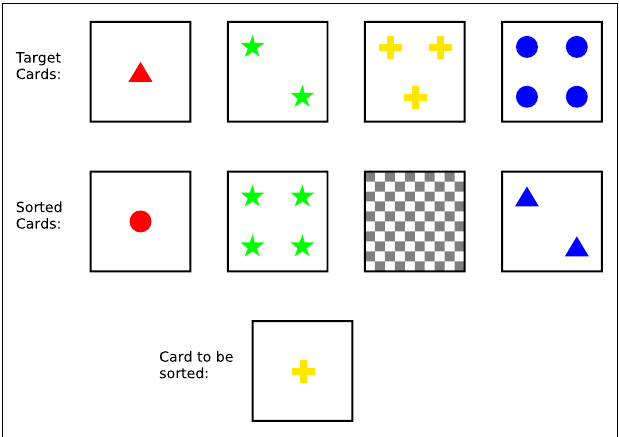
FIGURE 6 |TheWisconsin Card SortingTest. The four target cards are shown across the top row and four piles for sorted cards in the second row, the third of which is currently empty.The card to-be-sorted is at bottom. If the subject is sorting according to color or form, this card should be placed under the third target card, but if he/she is sorting according to number then it should be placed under the first target